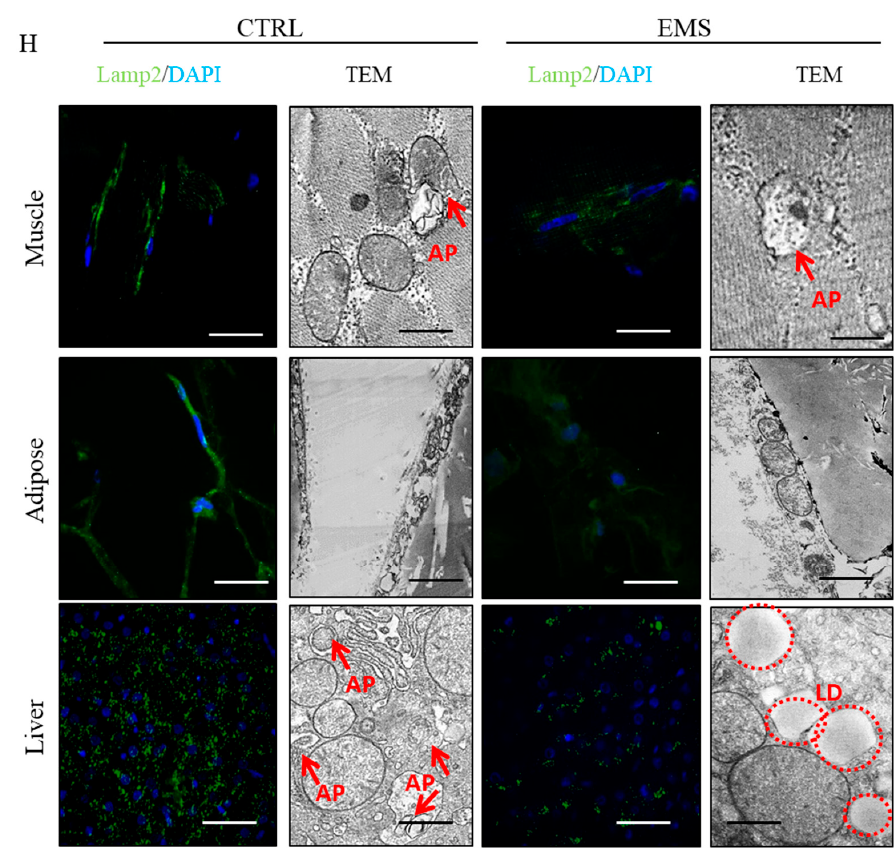
Figure 5. Evaluation of autophagy in muscle, adipose tissue and liver from healthy and EMS individuals. Using RT-PCR, the expression of mTOR ( A ), PI3K ( B ), AKT ( C ), Beclin-3 ( D ), LC3 ( E ), the ratio of Beclin/LAMP2 ( F ) and LAMP2 ( G ) was investigated. Using immunofluorescence, intracellular localization of LAMP2 in samples was examined ( H ). TEM analysis allowed for visualization of autophagosomes’ formation (indicated with red arrows ( I )). LD, lipid droplets; AP, autophagosomes. Results expressed as the mean ± S.D. * p < 0.05, ** p < 0.01, *** p < 0.001. Scale bars: confocal 20 µm, transmission electron microscope (TEM) 200